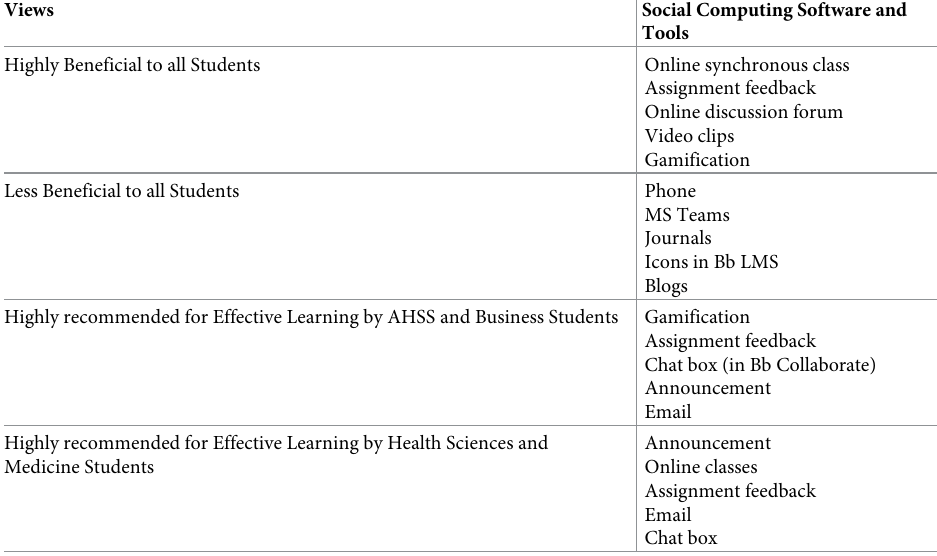
Table 2. A synopsis of students’ views and preference of social computing